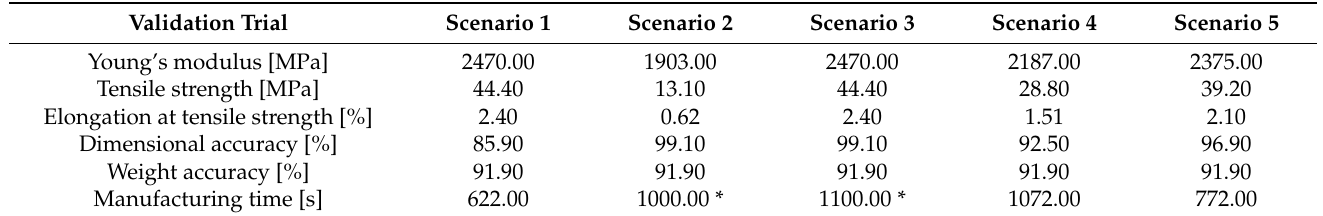
Table 4. Target values for the produced parts as input into the INN for parameter generation. Adjusted values deviating from the described procedure are marked with *.